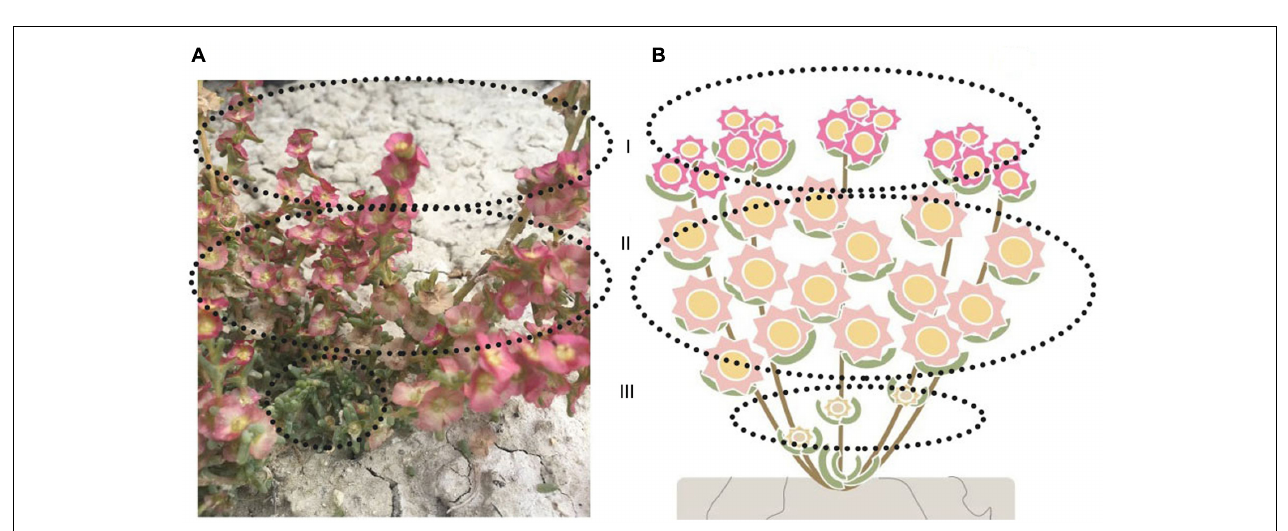
FIGURE 4 | Variation of seed heteromorphic ratio of S. ferganica collected from 2013, 2014 and 2015 calendar years in natural habitats. Different plants of S. ferganica randomly chosen at early stage of seed maturation for calculation of the ratio of heteromorphic seeds. Perc., percentage; Hetero., heteromorphic; No., number; L, M, S, large, middle, small seed; LT, light; DK, dark. (A) Percentage of heteromorphic seeds. (B) Heteromorphic seed number per plant. Bars with different lowercase letters indicate significant differences ( P < 0.05) according to the Tukey’s test. Values are means ± SE of four replicates.